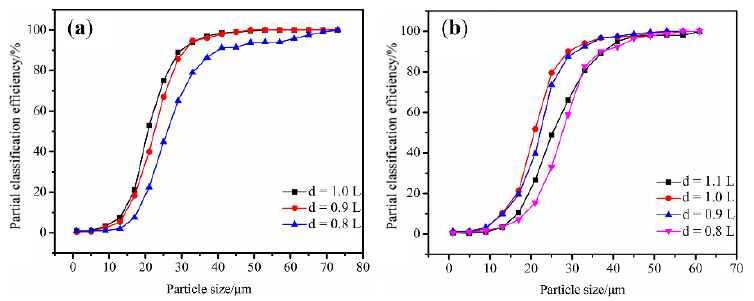
Figure 26. Tromp curves for different diameter diversion cone classifiers: ( a ) T-C (1-0.8) and ( b ) T-D (1-0.7).